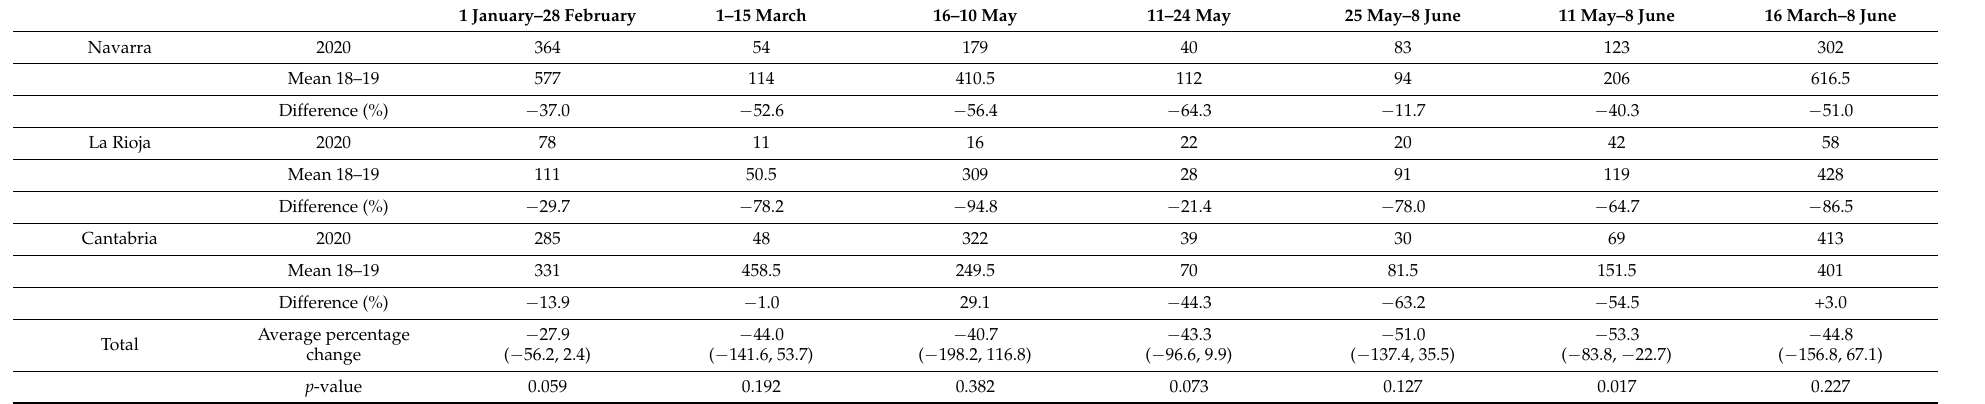
Table A3. Fresh frozen plasma distribution from the transfusion